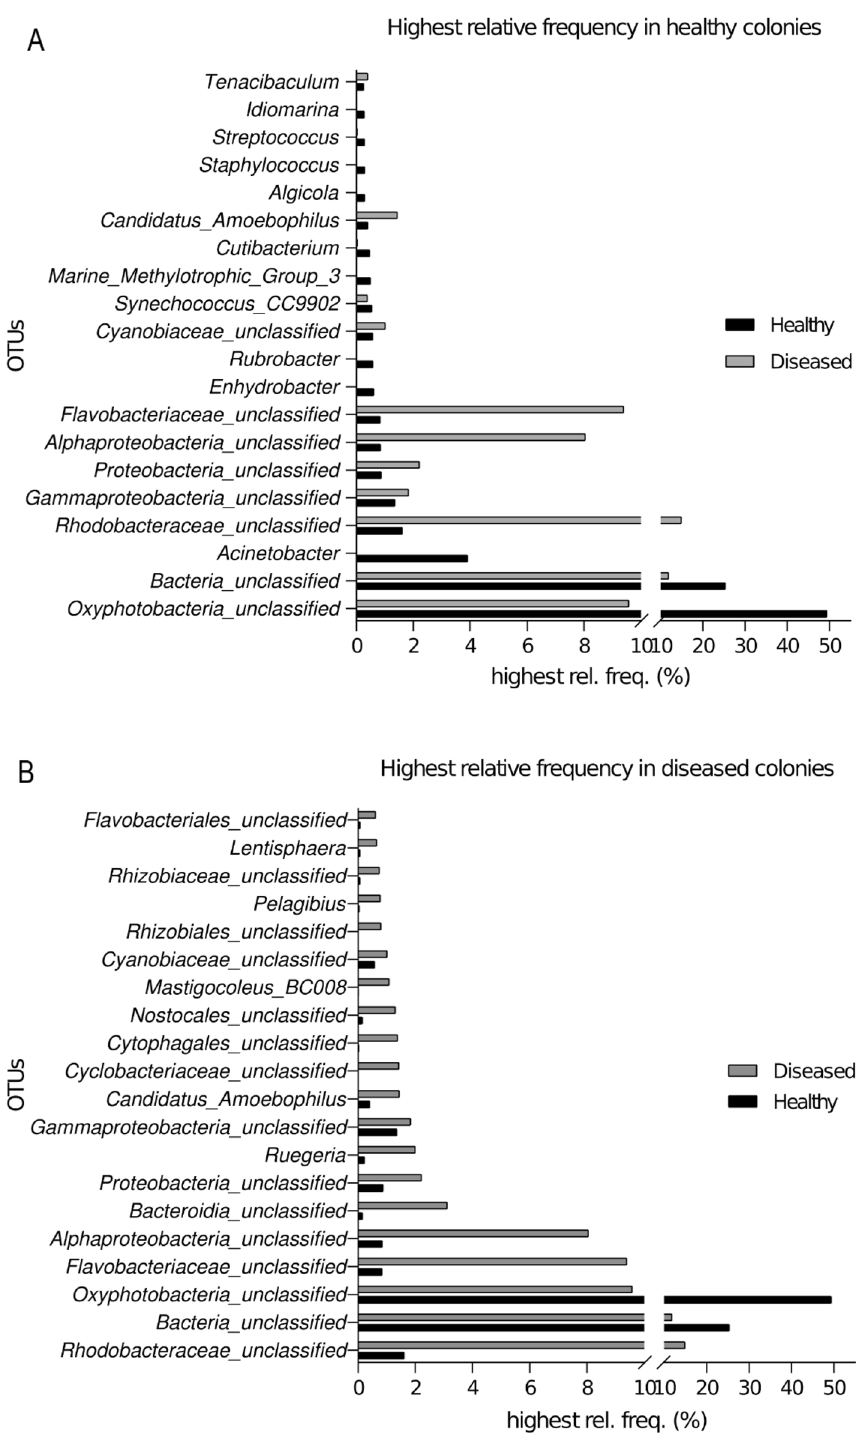
Figure 3. The 20 OTUs with the highest relative frequency in ( A ) healthy corals and their frequencies in diseased corals; and ( B ) associated with diseased corals and their frequencies in healthy corals. The figure was created using GraphPad Prism 8.0.2 (https:// www. graph pad.